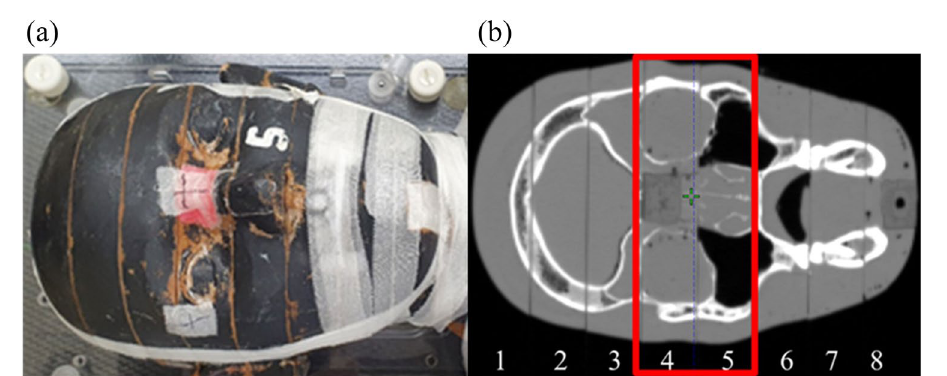
Figure 7. ( a ) Rando phantom and ( b ) CT image of the Rando